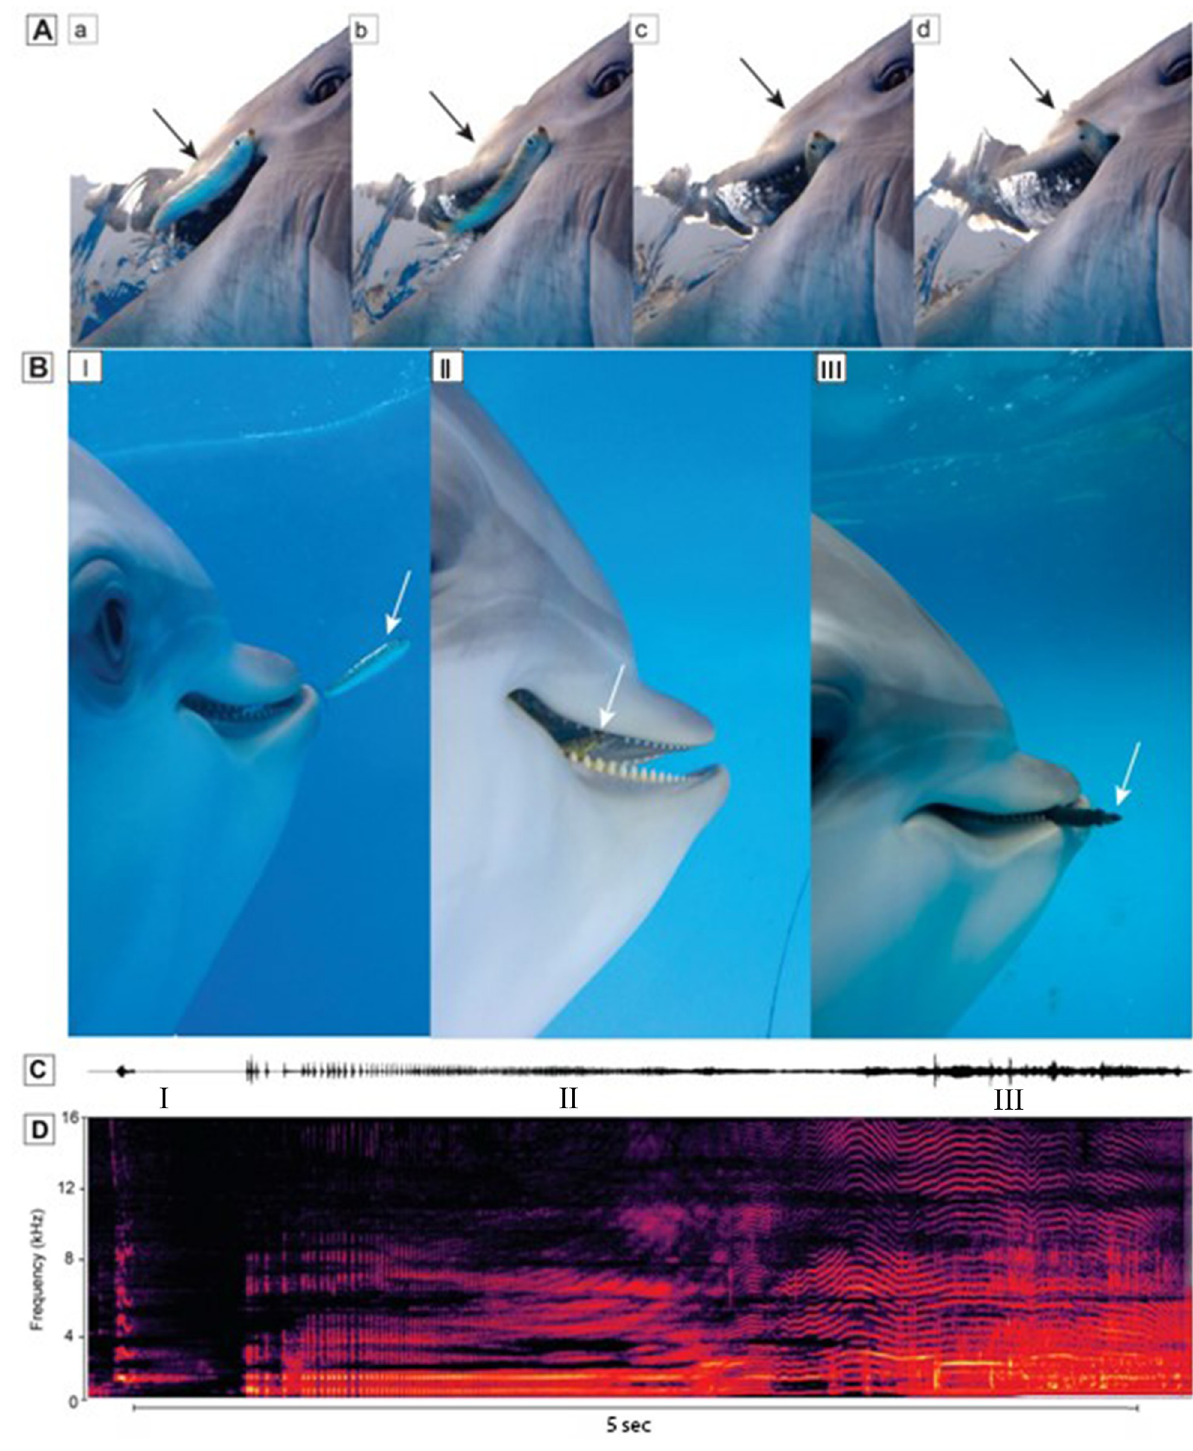
Fig 5. Dolphins capture live fish in a seawater pool. A . Dolphin B sequence (a, b, c, d) shows B sucking in a live fish (arrow) in his mouth. B . Dolphin T (a) locates a fish, right eye rotated forward. (b) Upon capture, the lower posterior lip is pulled down showing the gums and teeth and fish (arrow) inside the mouth. (c) The dolphin reorients the fish while still pulling the lip down and expanding the gular area apparently eliciting intraoral pressure reduction, yet the fish almost escapes. C. Relative amplitude of sound recorded from dolphin T during the capture observed in B . D . Audible frequencies of sound recorded from dolphin T during the capture observed in B